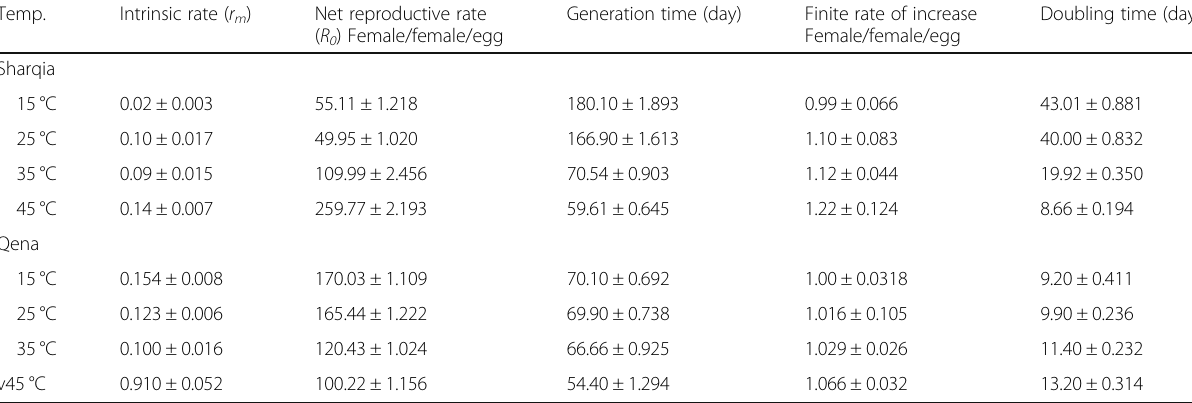
Table 3 Life table parameters for Ostrinia nubilalis under different constant temperature